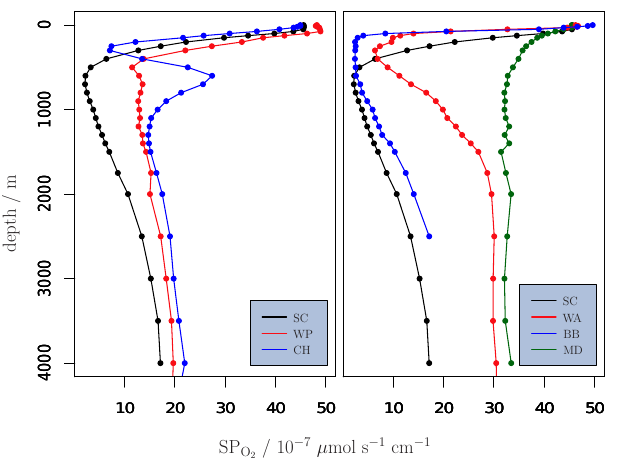
Fig. 2. Oxygen supply potential SP O Fig. 3. Generic maximal theoretical oxygen supply rate E max depth depth profiles of the wa- 2 profiles of the water column at different hydrographical stations ter column at different hydrographical stations around the world around the world (SC: Southern California (120.5 ◦ W, 29.5 ◦ N); (SC: Southern California (120.5 ◦ W, 29.5 ◦ N); CH: Chile (75.5 ◦ W, CH: Chile (75.5 ◦ W, 33.5 ◦ S); WP: Western Pacific (126.5 ◦ E, 33.5 ◦ S); WP: Western Pacific (126.5 ◦ E, 11.5 ◦ N), WA: Western 11.5 ◦ N), WA: Western Africa (6.5 ◦ E, 15.5 ◦ S), MD: Mediter- Africa (6.5 ◦ E, 15.5 ◦ S), MD: Mediterranean (18.5 ◦ E, 35.5 ◦ N); ranean (18.5 ◦ E, 35.5 ◦ N); BB: Bay of Bengal (87.5 ◦ E, 18.5 ◦ N))). BB: Bay of Bengal (87.5 ◦ E, 18.5 ◦ N)). A generic flow velocity of u 100 =2cms − 1 is assumed for all depths to calculate L . If available, detailed flow profiles can be used here, as well as organism-specific descriptions for L .